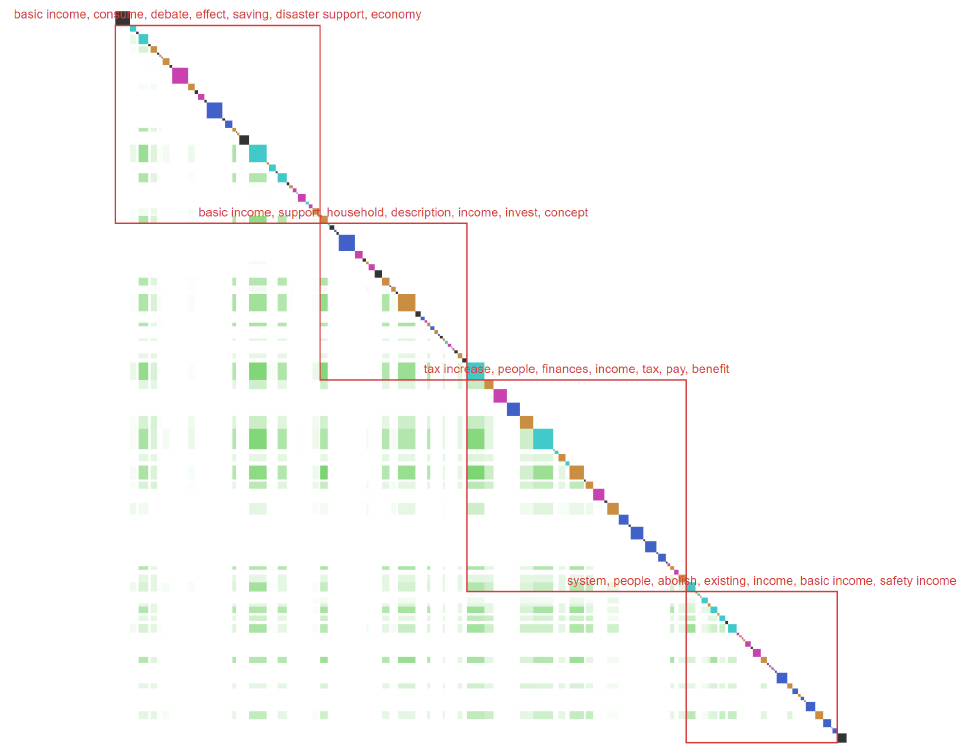
Figure 18. Conceptual similarities between Jaemyung Lee and Sehun Oh in the 100-Munite Debate “Is the era of basic income really